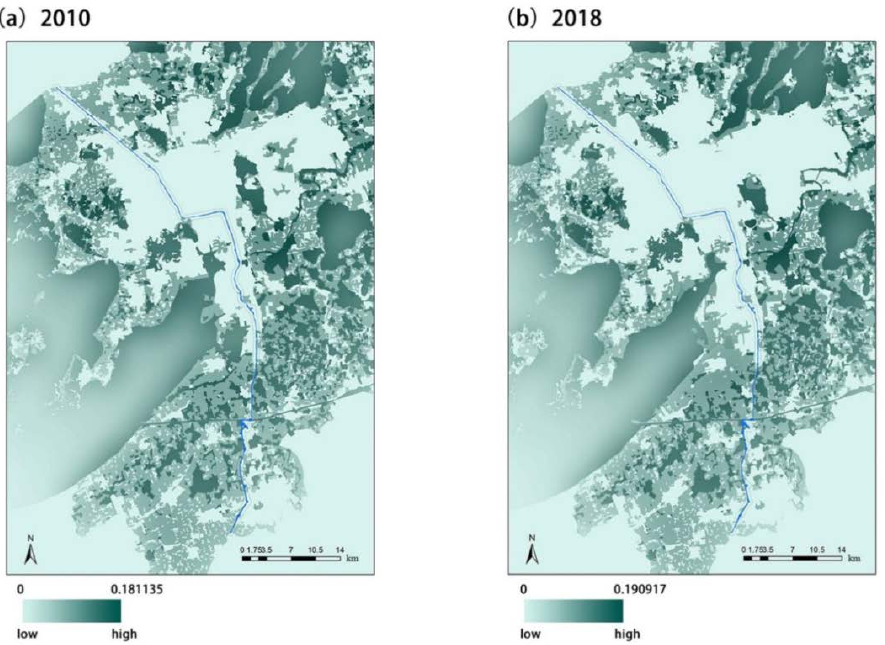
Figure 8. Index map of habitat degradation in study area between 2010 and 2018.